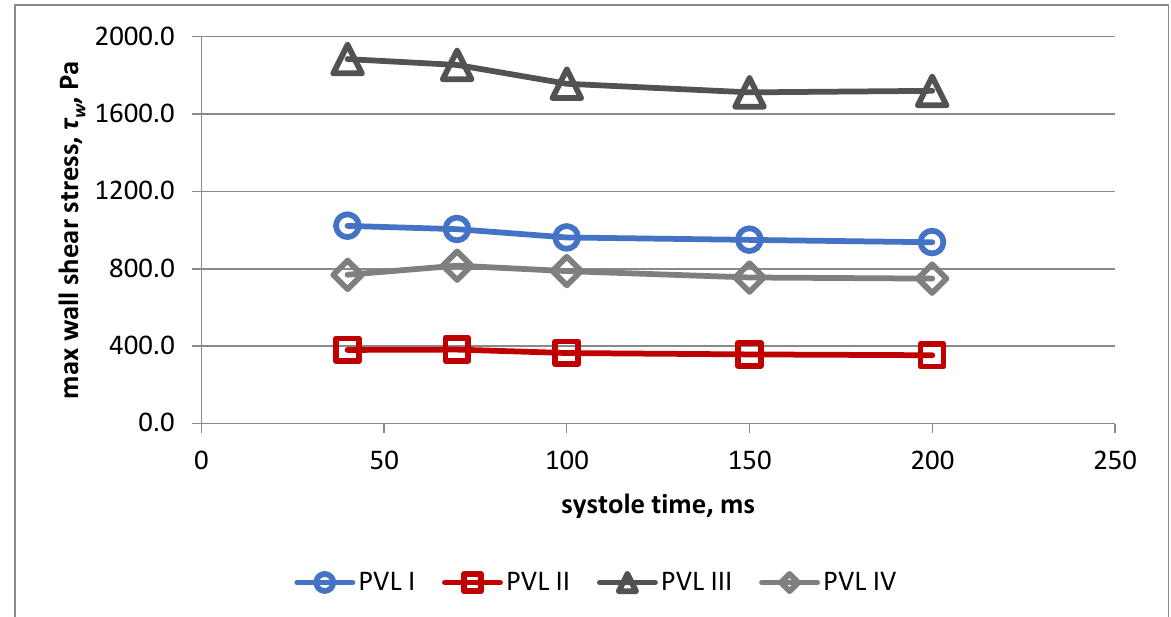
Figure 8. Maximal wall shear stress during systole for all PVL models.